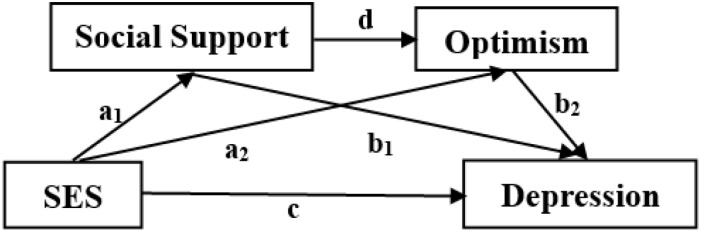
Visual representation of hypothetical model. Hypothesis 1 (H1) = total effect of socioeconomic status (SES) on depression (c); Hypothesis 2 (H2) = specific indirect effect through social support (a1b1); Hypothesis 3 (H3) = specific indirect effect through optimism (a2b2); Hypothesis 4 (H4) = serial mediating effect (a1db2).